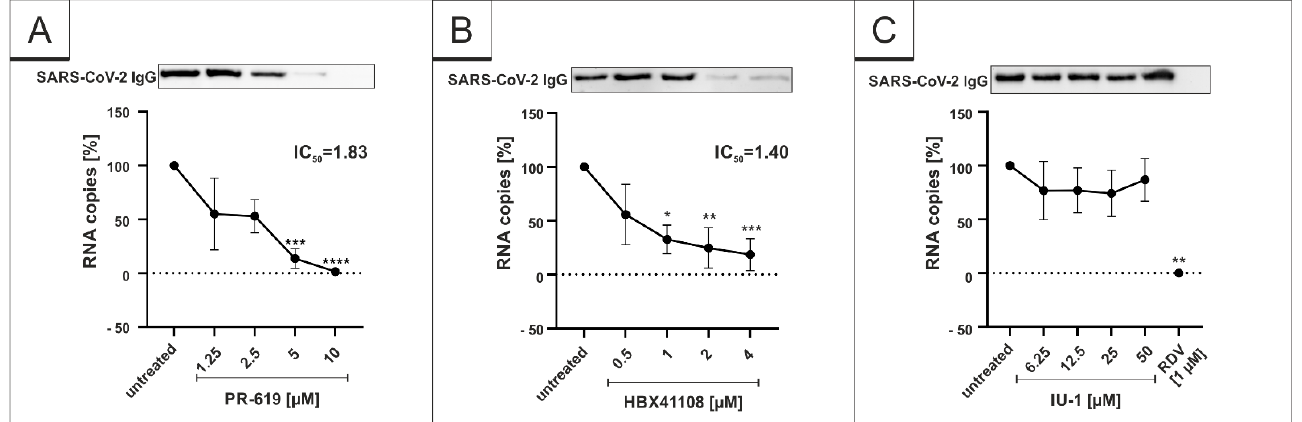
Figure 1. PR-619 and HBX41108 inhibit SARS-CoV-2 replication in Vero B4 cells. qRT-PCR of cell culture supernatants and Western blot analysis of released virions after treatment with ( A ) PR-619, ( B ) HBX41108 and ( C ) IU1. Remdesivir (RDV) was used as a positive control ( C ). One representative Western blot is shown. Cell culture supernatants were harvested 3 days postinfection (dpi). The virions were purified and analyzed by Western blot using a SARS-CoV-2 convalescent serum. Bars show mean values of five ( A , B ) or three ( C ) independent experiments ±